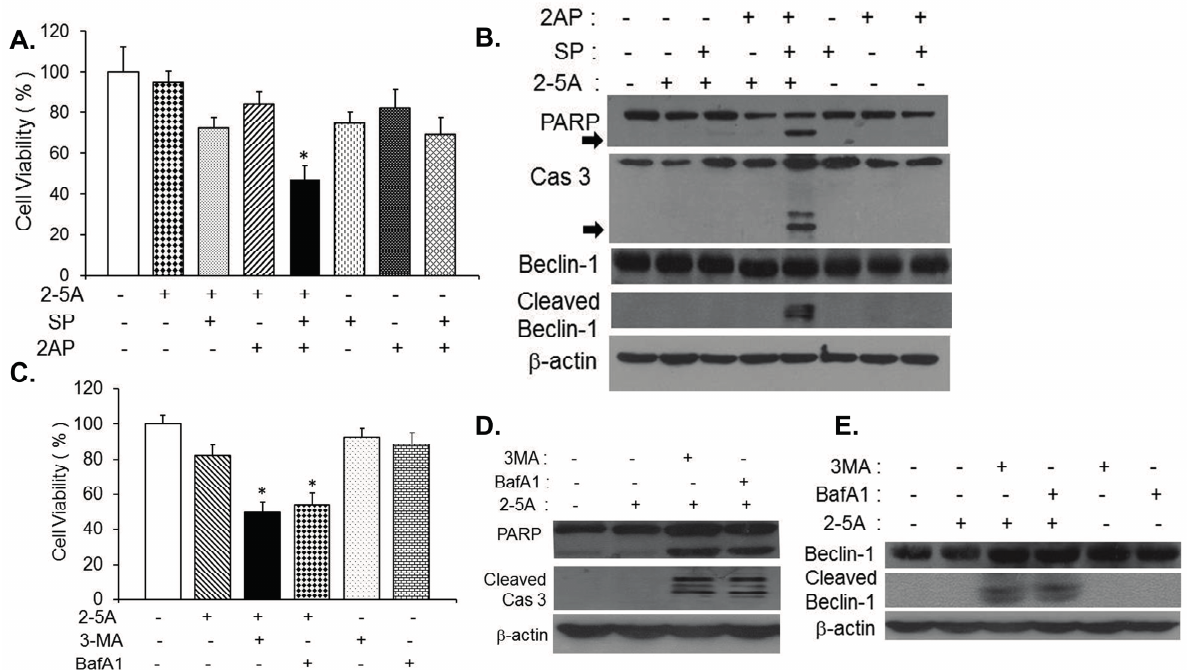
Figure 3. Inhibiting RNase L-induced autophagy activates caspase 3 to cleave Beclin-1. HT1080 cells were pretreated with PKR inhibitor (2-aminopurine, 5 mM), JNK inhibitor (SP600125, 25 µM) or with 2AP and SP600125 combined for 1h prior to 2–5A transfection (10 µM) for 8 h. ( A ) Cell viability was determined by MTT assay.